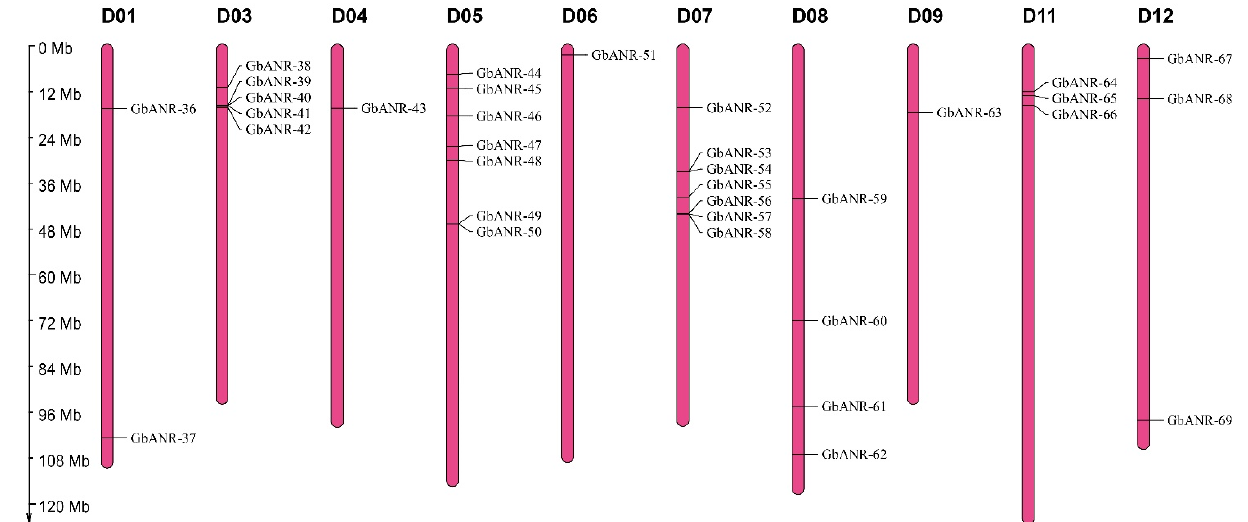
Figure 1. Chromosomal localization of G. barbadense ANR genes.